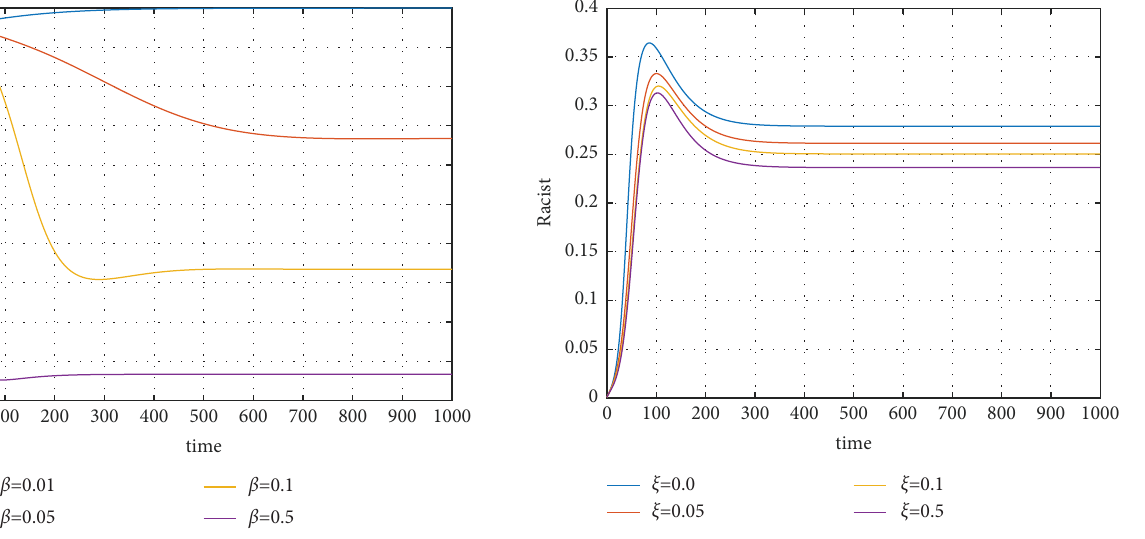
Figure 8: Te impact of β on the total susceptible.